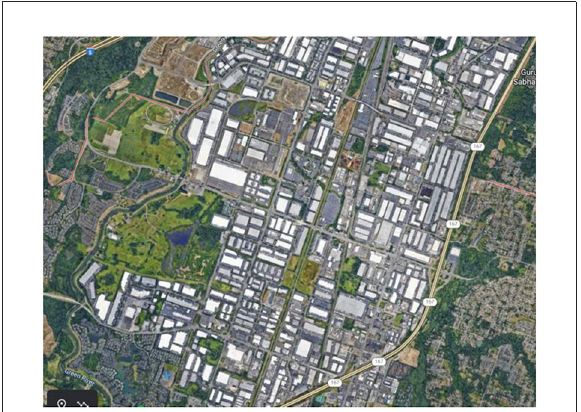
FIGURE3 Kent, Washington’s spatial structure: broadening sustainability relationally? (Source: Good